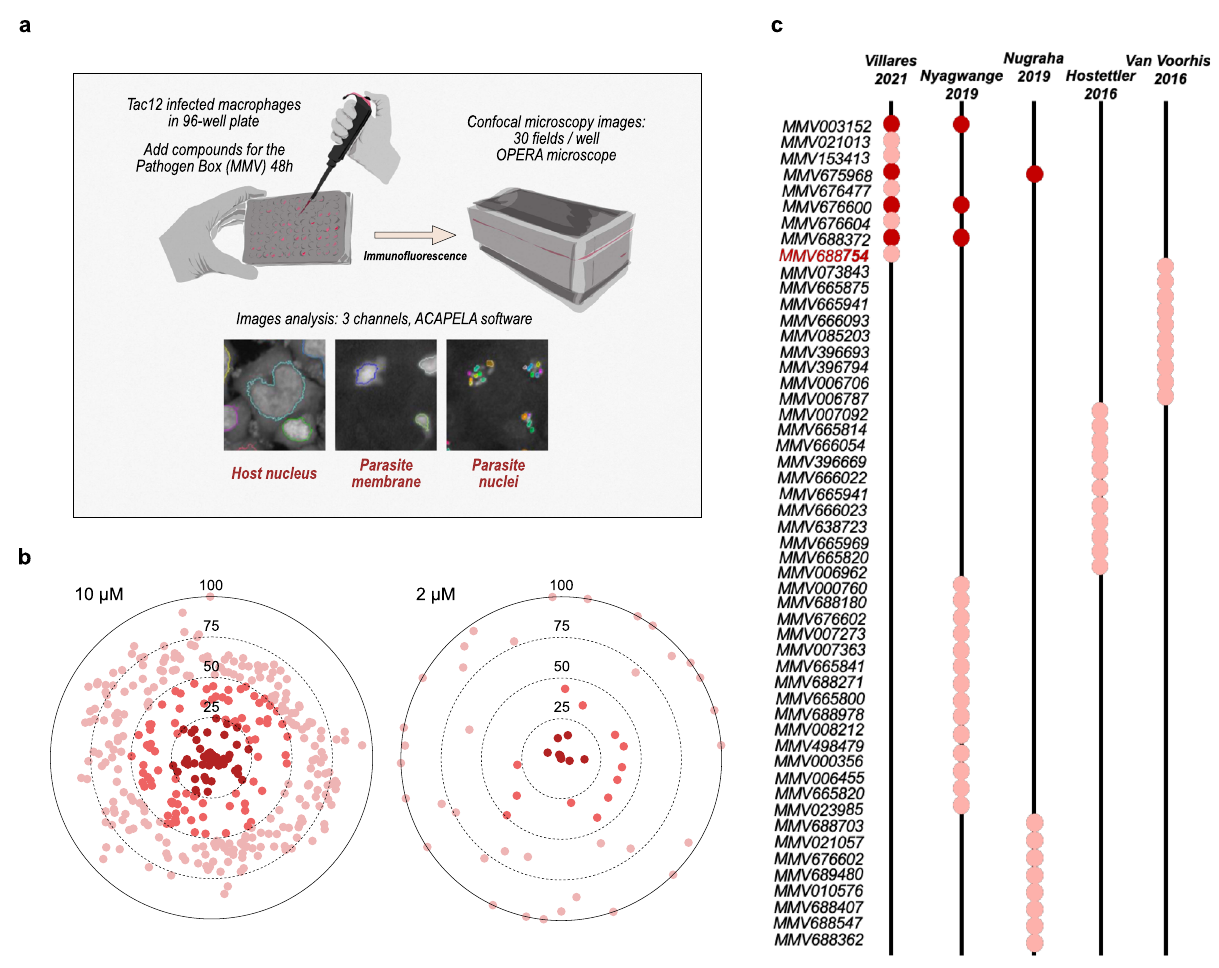
Fig. 1 Screening MMV Pathogen Box compounds against Theileria -infected macrophages. a A schematic presentation of the different steps of the microscopy-based drug screen. T. annulata -infected macrophages (TaC12 cell line) were distributed into 96-well plates and imaged after incubation (48 h) with compounds from the MMV Pathogen Box library at two concentrations. The screen involved identifying and segmentation of host cell nuclei (DAPI staining), the macroschizont membrane (CLASP-GFP fusion protein) and parasite nuclei (H3K18me1 staining). b TaC12 cells treated with MMV Pathogen Box compounds at two concentrations (10 µ M or 2 µ M) for 48 h. Host cell survival was calculated by comparing the number of host cell nuclei per fi eld with control (DMSO-treated) cells. Results are plotted for percent host cell survival, with the darkest spots representing compounds causing <25% survival. c Comparison of our results with previous MMV screening reports for Theileria -infected cells. The hit compounds from screens conducted against cells infected with T. equi (Van Voorhis et al. 4 , Nugraha et al. 28 ), T. parva (Nyagwange et al. 26 ) or T. annulata (Hostettler et al. 27 ) are indicated as circles. Hits detected in more than one screen are indicated in dark red. The complete list of compounds is shown in Supplementary Table